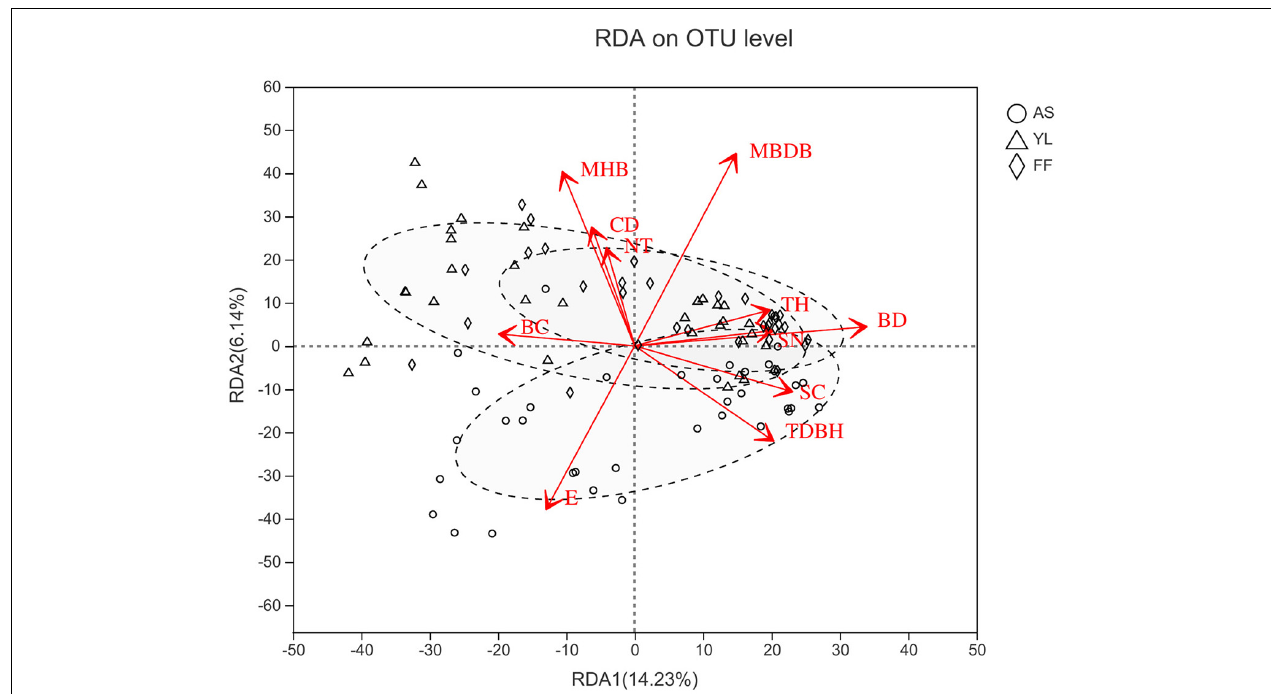
FIGURE 5 | Redundancy analysis (RDA) between environmental factors and phyllosphere bacterial communities at OTU level among A. spanostachya (AS), Y. lineolate (YL), and F. ferax (FF). E, elevation; TH, trees height; TDBH, trees diameter at breast height; SN, shrubs numbers; MHB, mean height of bamboo; MBDB, mean base diameter of bamboo. CD, canopy density; BC, bamboo coverage; BD, bamboo deaths; NT, number of trees.